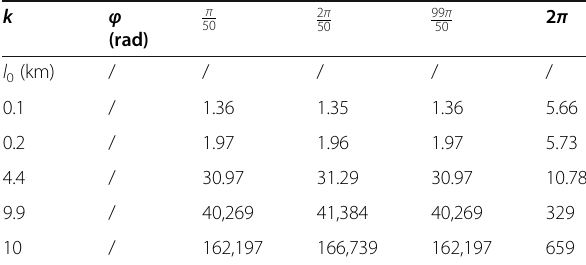
Table 1 The value of amplitude